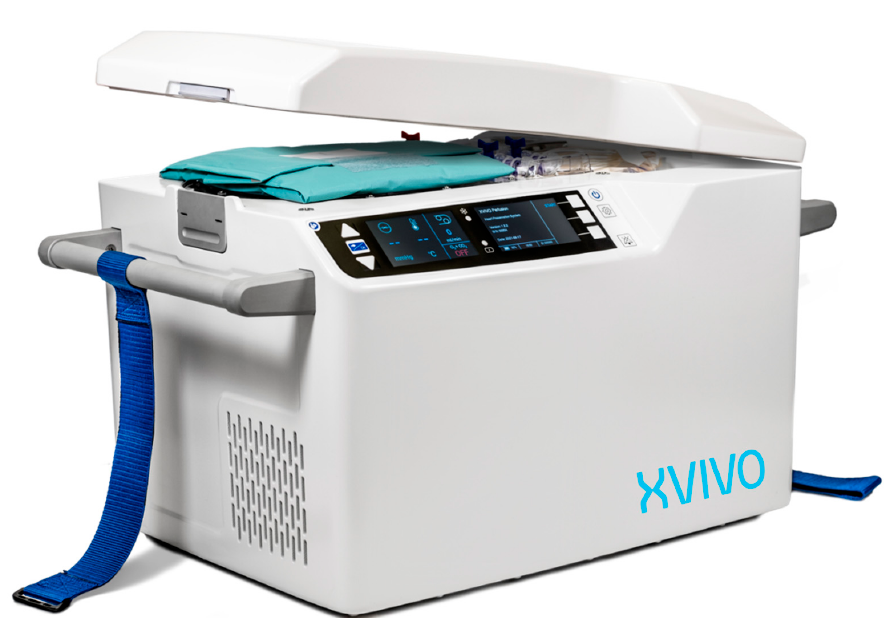
Figure 3. XVIVO Heart Perfusion System. The heart is submerged in cold blood and cardioplegia solution. Continuous, hypothermic perfusion is established via the aortic root during transport. Photograph used with permission from XVIVO Inc.